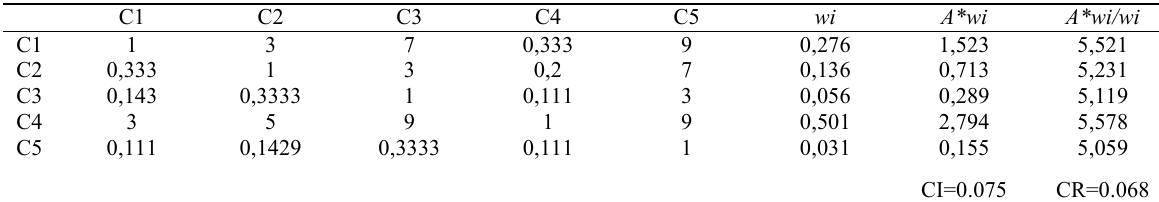
Table 1. Pairwise comparisons of selection